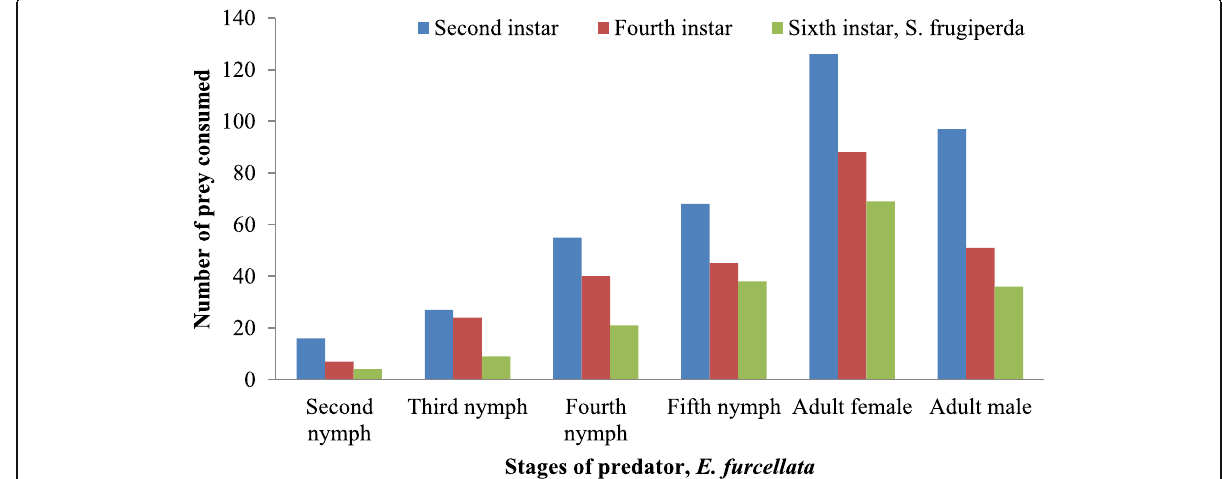
Fig. 2 Feeding potential of the predatory bug. E. furcellata on different larval instars of S.